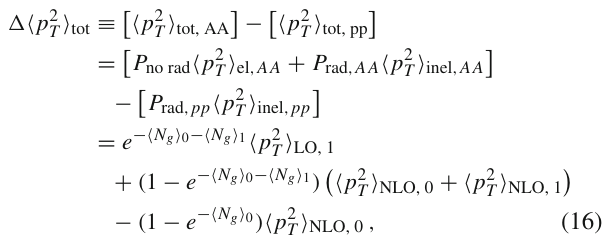
interactions with the medium are representative of all possible attach- ments of the gluon exchange from the medium. The vacuum contribu- tion is explicitly removed